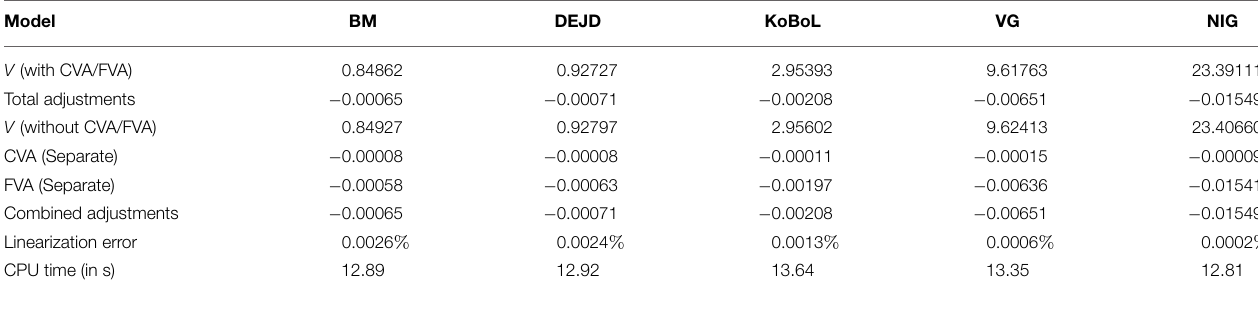
TABLE 10 | Prices of at-the-money down-and-out put for different models as of 28 May 2015, time to maturity T = 0 . 0877 , spot S = 27 , 454 . 31 , strike K = 27 , 400 , barrier H = 27 , 000 , risk-free rate r = 0 . 25 % , collateral rate r C = 1 % , funding rate r F = 1 . 7 % default intensity λ = 0 . 05 , recovery rate R B = 0 . 4 , collateral threshold H B = 0 . 1